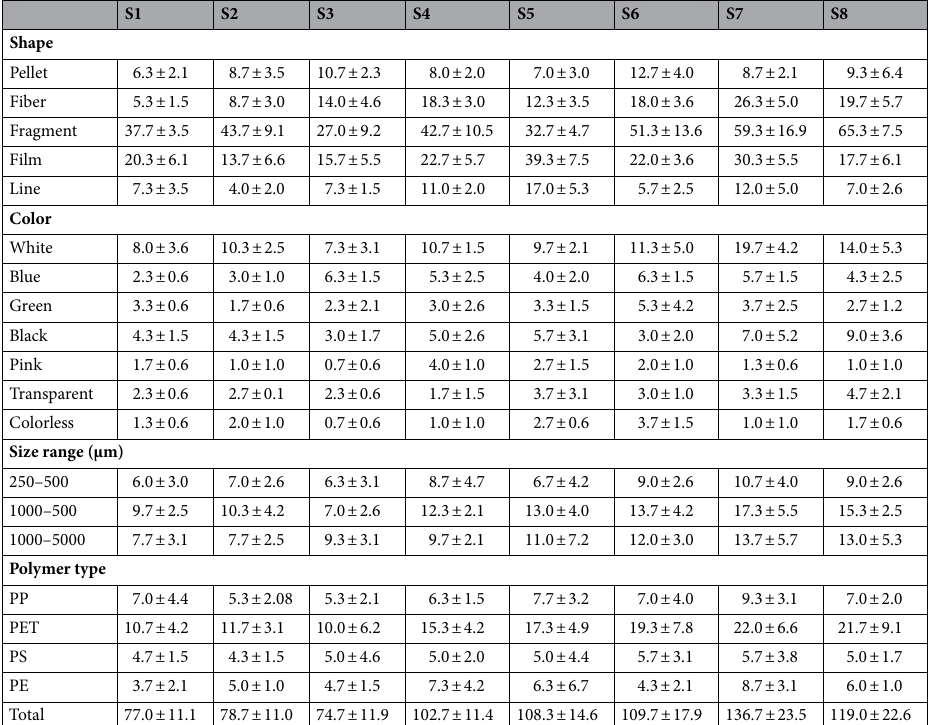
Table 1. Microplastic abundance (Particles kg −1 ) (Mean value ± SD) by shape, color, size range and, polymer categories in unpacked coarse salt samples from stations S1 to S8 (n =